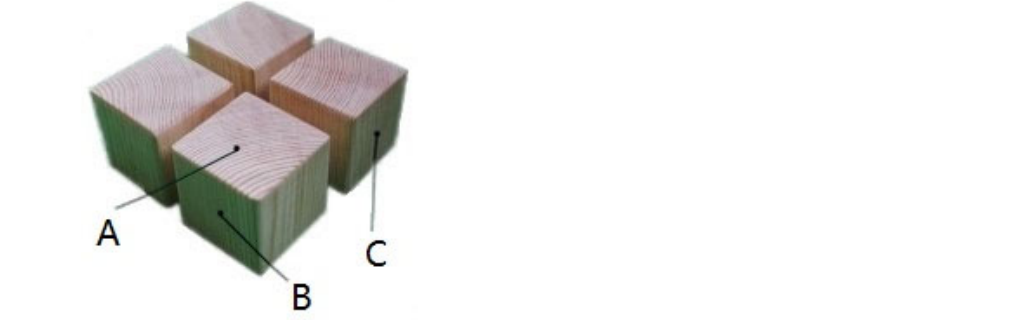
Figure 2. Schematic of different scanning section. A—Transverse Section, B—Radial Section, C—Tangential Section.